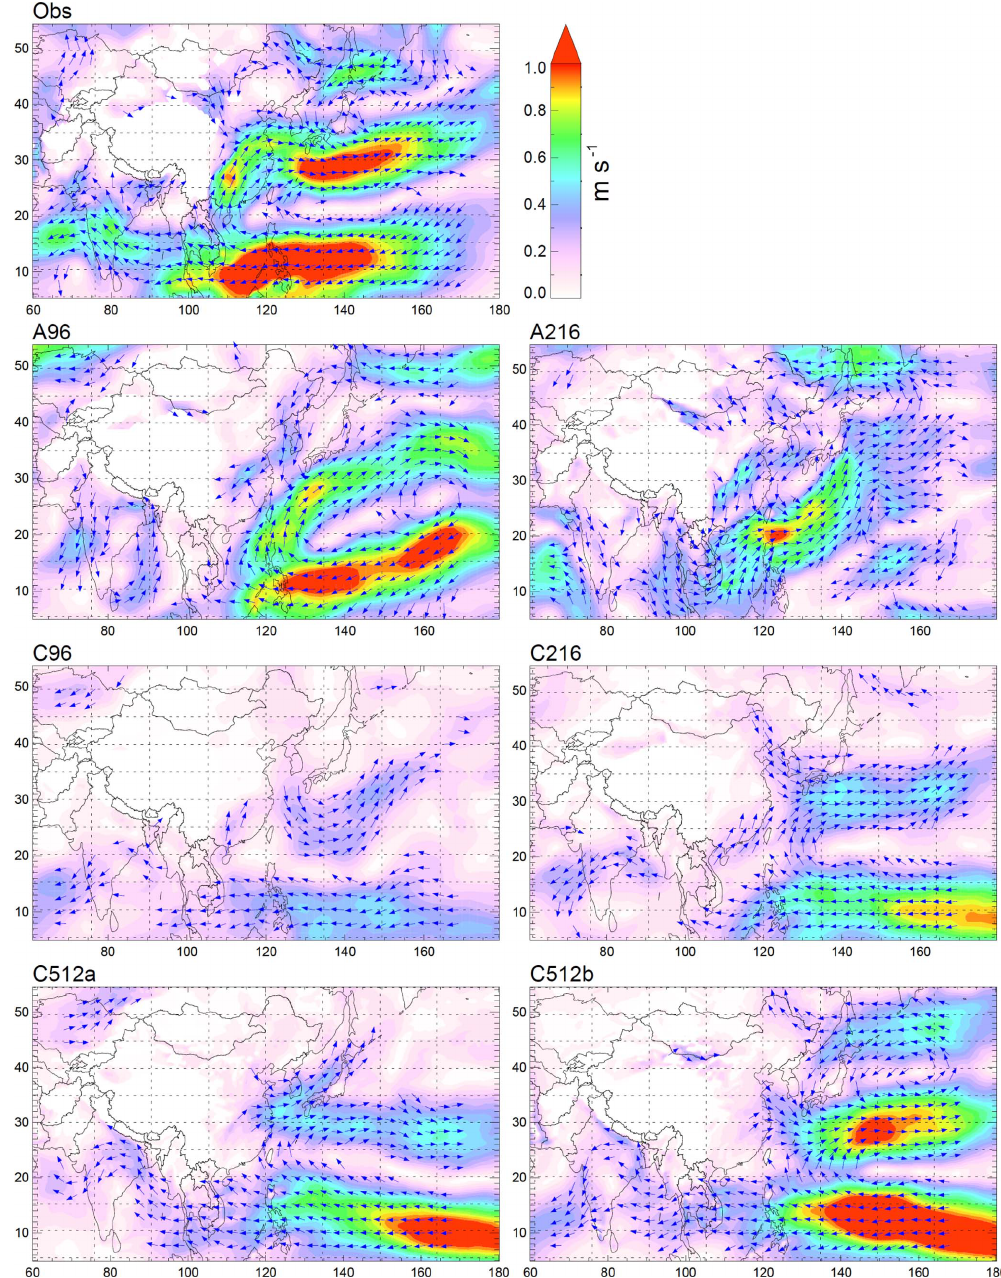
Figure 5. Regression of observed or simulated JJA 850hPa wind against observed or simulated normalised DJF Niño3.4. Observations use 1982–2008 to match the years of the atmosphere-only simulations. Arrows indicate the wind direction and are drawn where wind speeds exceed 0.2ms − 1